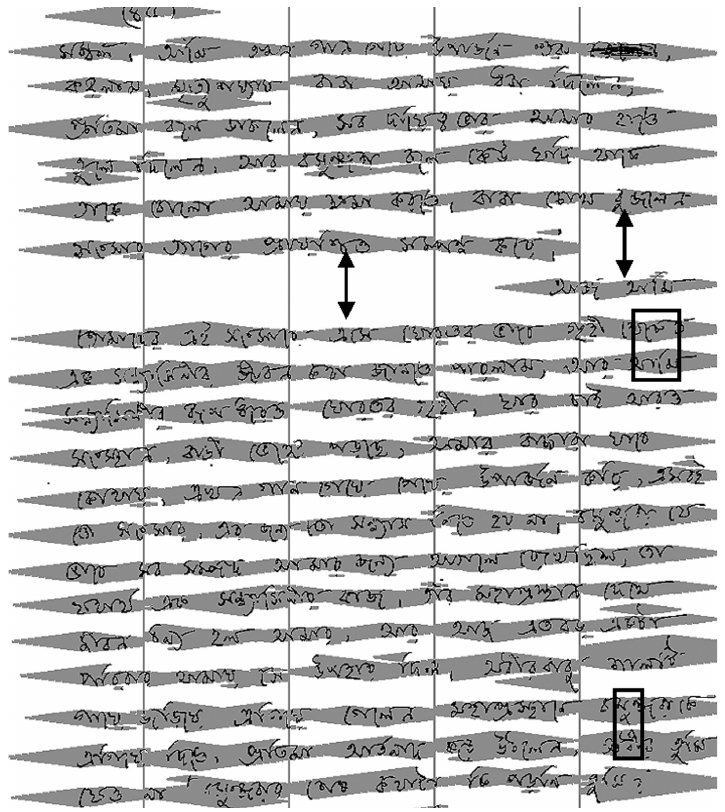
Figure 6. Variations in Text Line Spacing in a Handwritten Document Are Shown. Boxes Indicate Small Gaps and Arrows Indicate Large